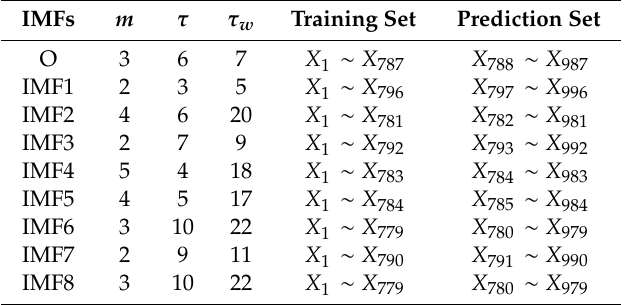
Table 5. Reconstruction parameters and datasets of raw data and IMFs decomposed by EMD.